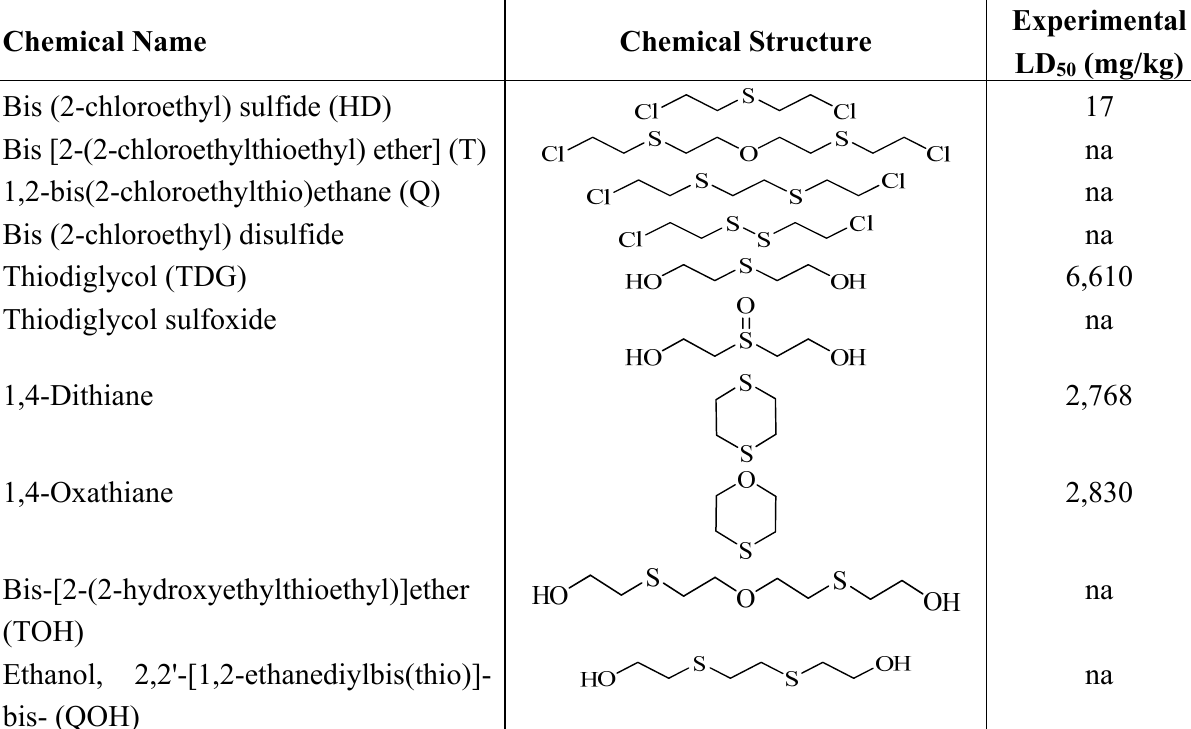
Table 1. Chemical name, structures and experimental LD